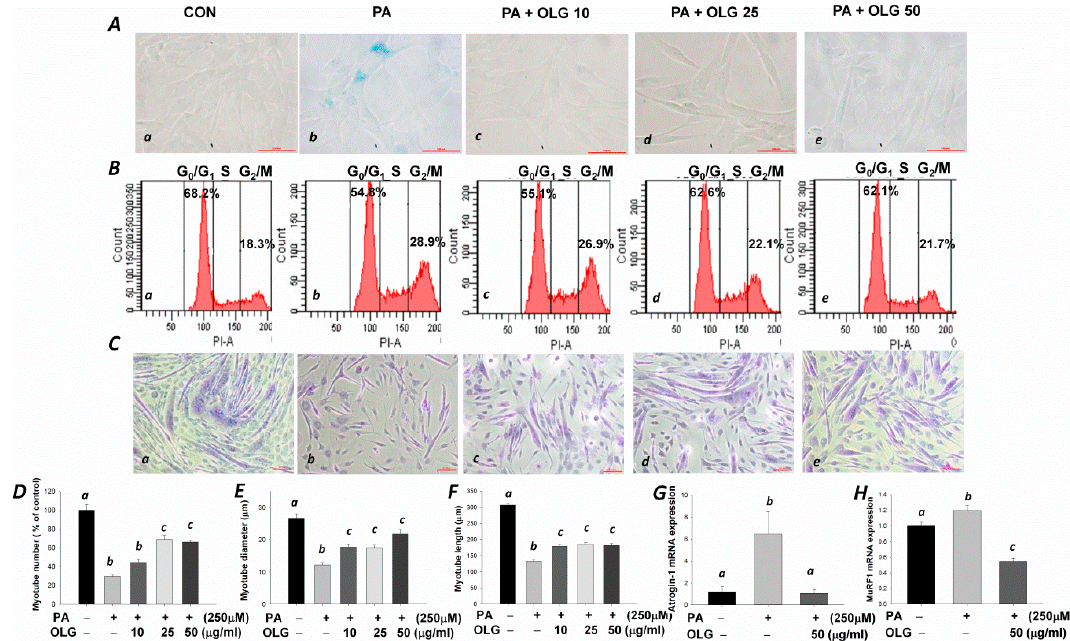
Figure 5. C2C12 myoblasts were pretreated with or without oligonol (10, 25, 50 μ g/mL) for 16 h, followed by incubation with or without palmitate (PA, 250 μ M) for 8 h. ( Aa – e ) Senescence-associated β -galactosidase positive cells exhibited blue-green color (400×); ( Ba – e ) The relative percentage of myoblasts at G0/G1, S, and G2/M phases of the cell cycle; ( Ca – e ) Myoblasts received different treatments during the proliferative phase were differentiated into myotubes; After 5 days of differentiation, crystal violet staining was used to examine myotube formation (100×); ( D – F ) Quantification of myotube number, diameter, and length, respectively; ( G , H ) Atrogin-1 and MuRF1 mRNA levels in differentiated C2C12 myotubes treated with PA and/or oligonol. Fold differences were calculated using the ΔΔ Ct method. Values presented are mean ± SEM ( n = 3/group).